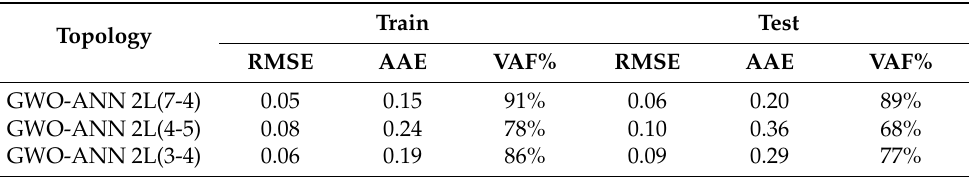
Table 13. Statistics of top three artificial neural networks combined Grey Wolf Optimizer on training and testing data.